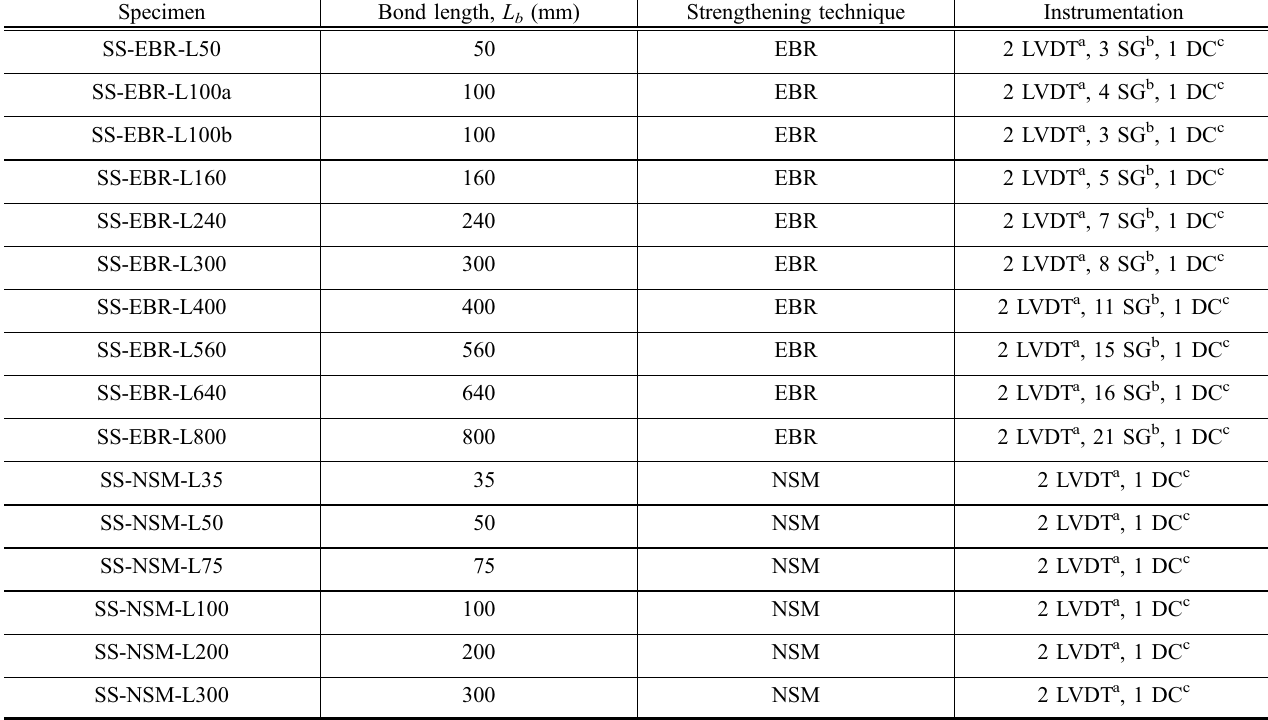
Table 1 Single-lap shear tests.